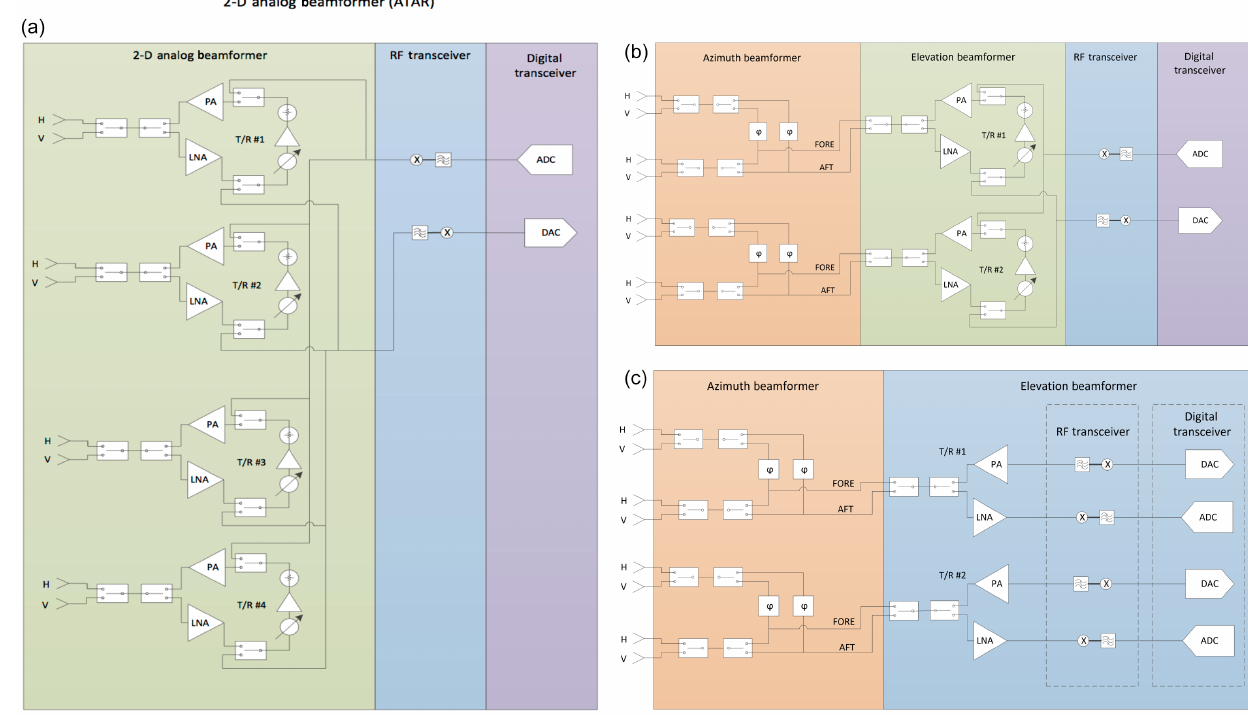
Figure 9. APAR architectures for ATAR configuration: (a) 2-D analog, (b) 1-D analog, and (c) 1-D